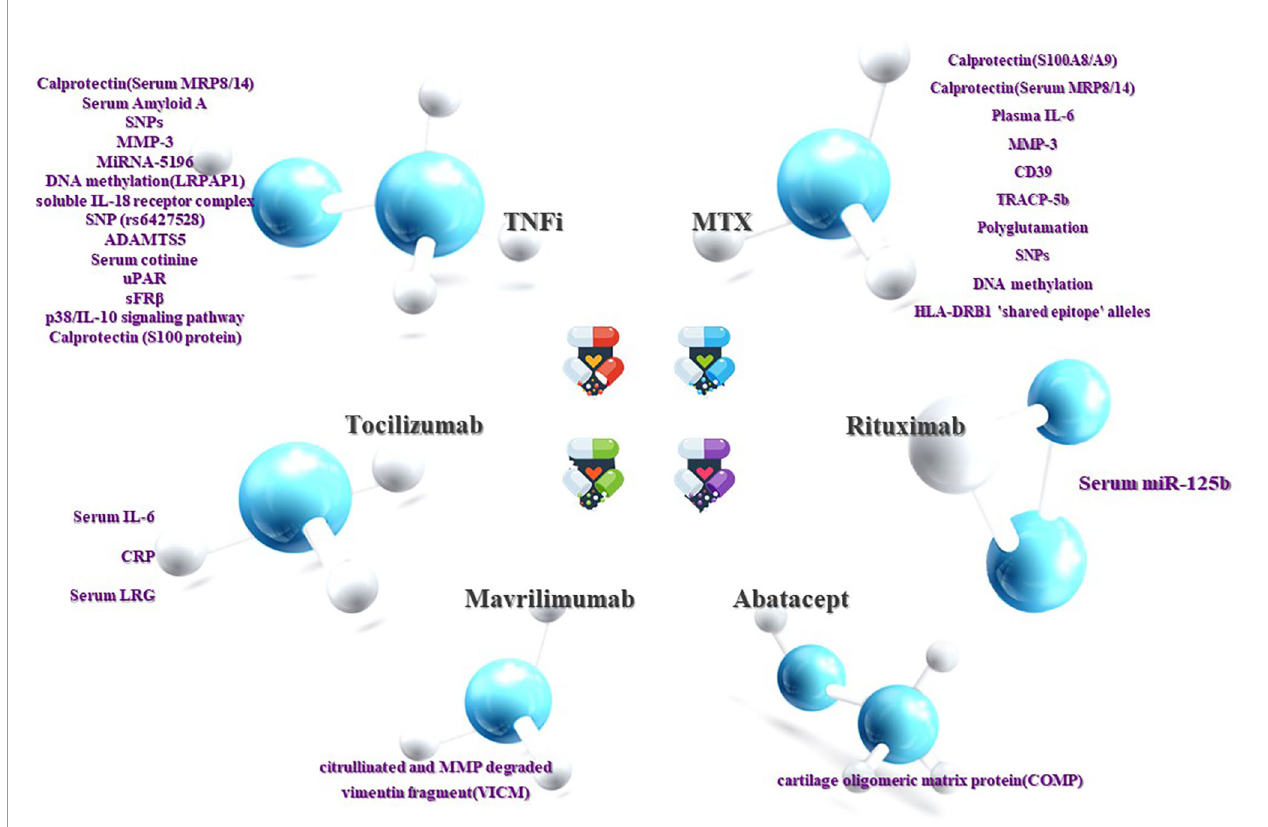
FIGURE 1 | Prediction of RA ef fi cacy by biomarkers. The ability to in fl uence clinical decision-making is dependent on the response or non-response of RA patients to DMARDs drugs. Although current research on the treatment of non-responsive biomarkers is not as suf fi cient and accurate as the former, it can still be used as a supplement. Both are bene fi cial in clinical decision-making and complement each